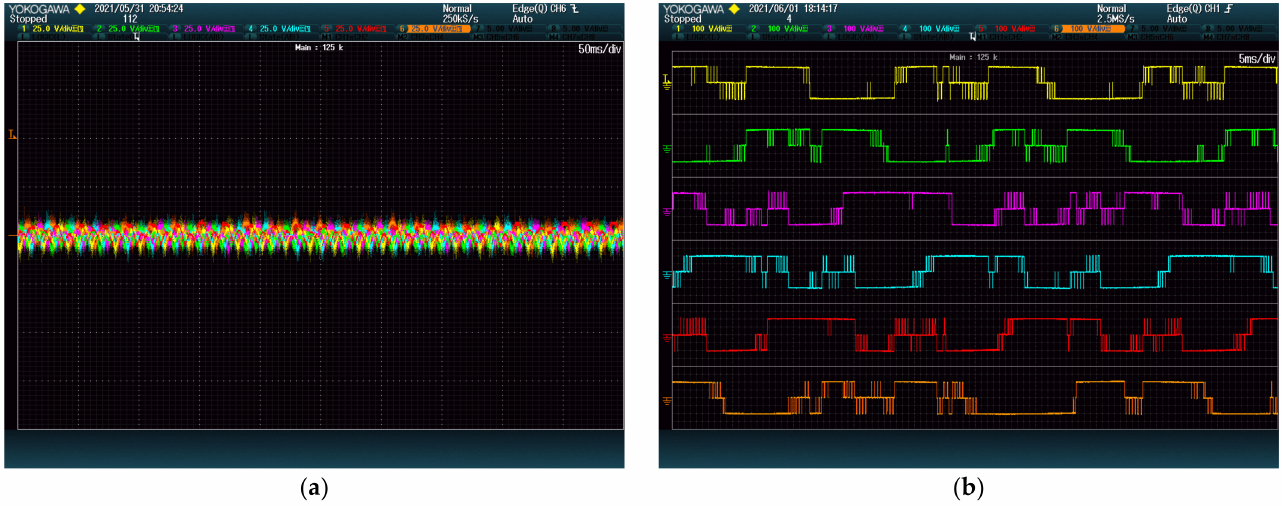
Figure 5. Second test results, with small gain for switching reduction on all modules ( G Skj = 0.01): ( a ) DC- link voltage ripple (25 V/dv) vs. time (50 ms/div); ( b ) Modules output voltages for 2.5 grid